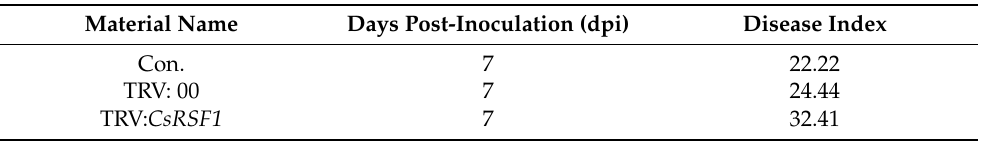
Table 2. Disease index investigation for CsRSF2 transient silencing cucumber cotyledons after S. fuliginea infection.